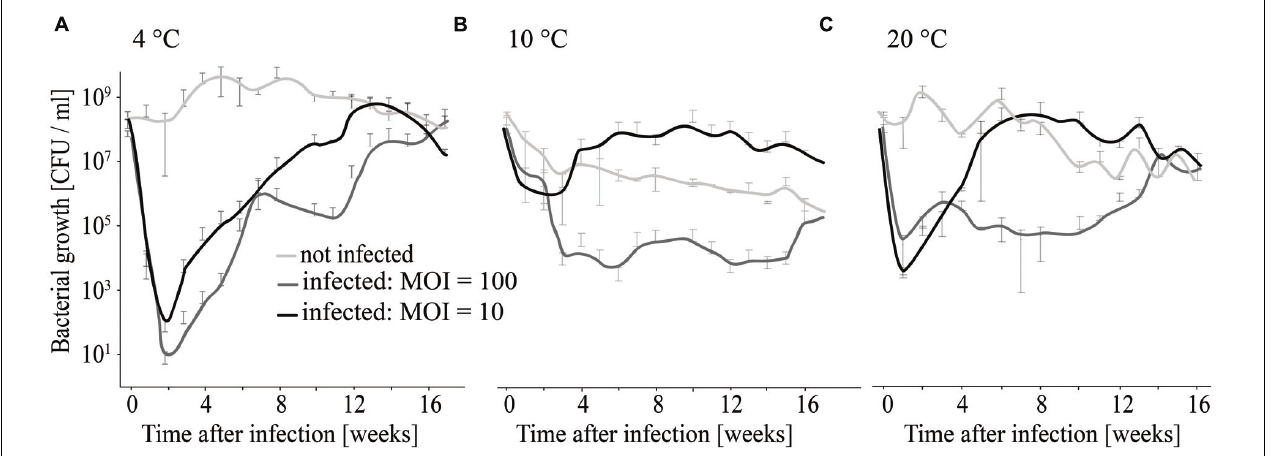
FIGURE 7 | Long-term infection experiment using different MOIs and temperatures for incubation. Growth of infected and non-infected L. monocytogenes was monitored at 4 ◦ C (A) , 10 ◦ C (B) , and 20 ◦ C (C) .